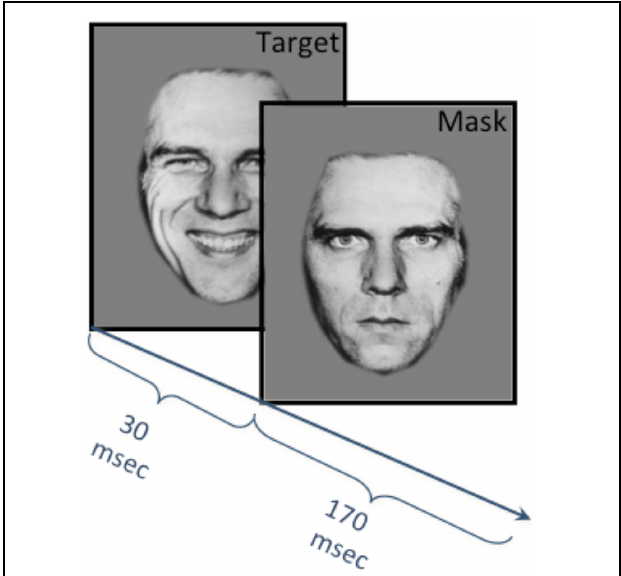
FIGURE 1 | Masked facial affect task methods. Five alternating blocks of neutral (N) and emotional (E) masked target stimuli were presented during fMRI acquisition in the following fixed order: N,E,N,E,N. Each block consisted of 10 stimuli, and each stimulus consisted of either an emotion (happy angry or fearful) or neutral target face presented for 30 ms, followed immediately by a neutral masking face (i.e., neutral and emotion faced merged) for 170 ms with an inter-trial interval of 2800 ms. Emotional targets were matched for emotional state across all E blocks, and therefore each participant completed three runs of the task for each non-neutral emotional state (happy, fear, and